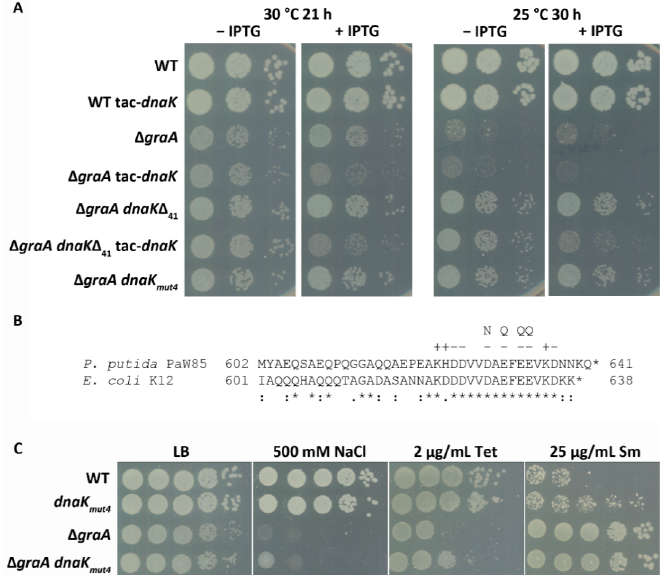
Figure 2. The conserved C -terminal domain of the DnaK is important for GraT toxicity. ( A ) Growth assay on a solid medium of the P. putida wild-type PaW85 (WT), ∆ graA and their derivatives encoding the tac- dnaK overexpression cassette as well as ∆ graA dnaK ∆ 41 and ∆ graA dnaK mut4 strains encoding the DnaK with truncated or mutated C -terminus, respectively. Tenfold dilutions were spotted onto lysogeny broth (LB) medium and LB supplemented with 0.5 mM IPTG. Agar plates were incubated at 30 ◦ C or 25 ◦ C for indicated times. ( B ) Sequence alignment of P. putida PaW85 and E. coli K12 DnaK chaperone C -terminal ends. The charged amino acids in the conserved C -terminal motif are marked with “ − “ and “+”. The four substitution mutations (D629N, E631Q, E633Q and E634Q) in the motif are indicated by N and Q. ( C ) Solid medium stress tolerance assays of P. putida wild-type, ∆ graA and their dnaK mut4 derivatives. Tenfold serial dilutions of the overnight cultures were spotted onto LB medium and on LB supplemented with NaCl, tetracycline or streptomycin. Final concentrations of the chemicals are indicated. Plates were incubated at 30 ◦ C for 24 h (LB) or 48